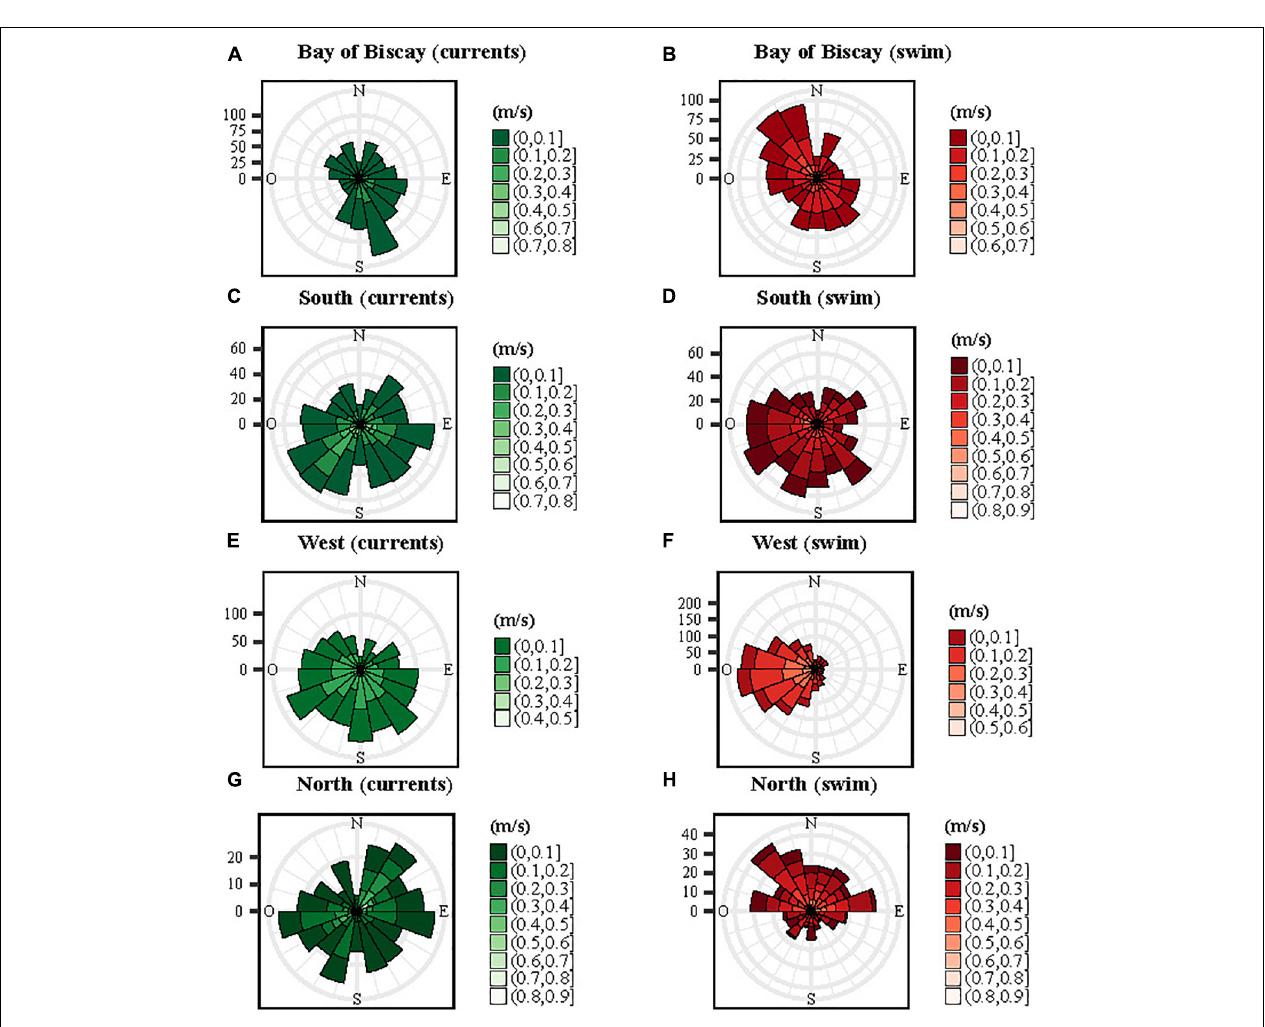
FIGURE 6 | Rose diagram frequency distributions of ocean currents (in green) and turtles (in red) orientation and velocity (in m/s) for the four spatial patterns: Bay of Biscay (A,B) , South (C,D) , West (E,F) and North (G,H) . The currents were extracted at each turtle location.